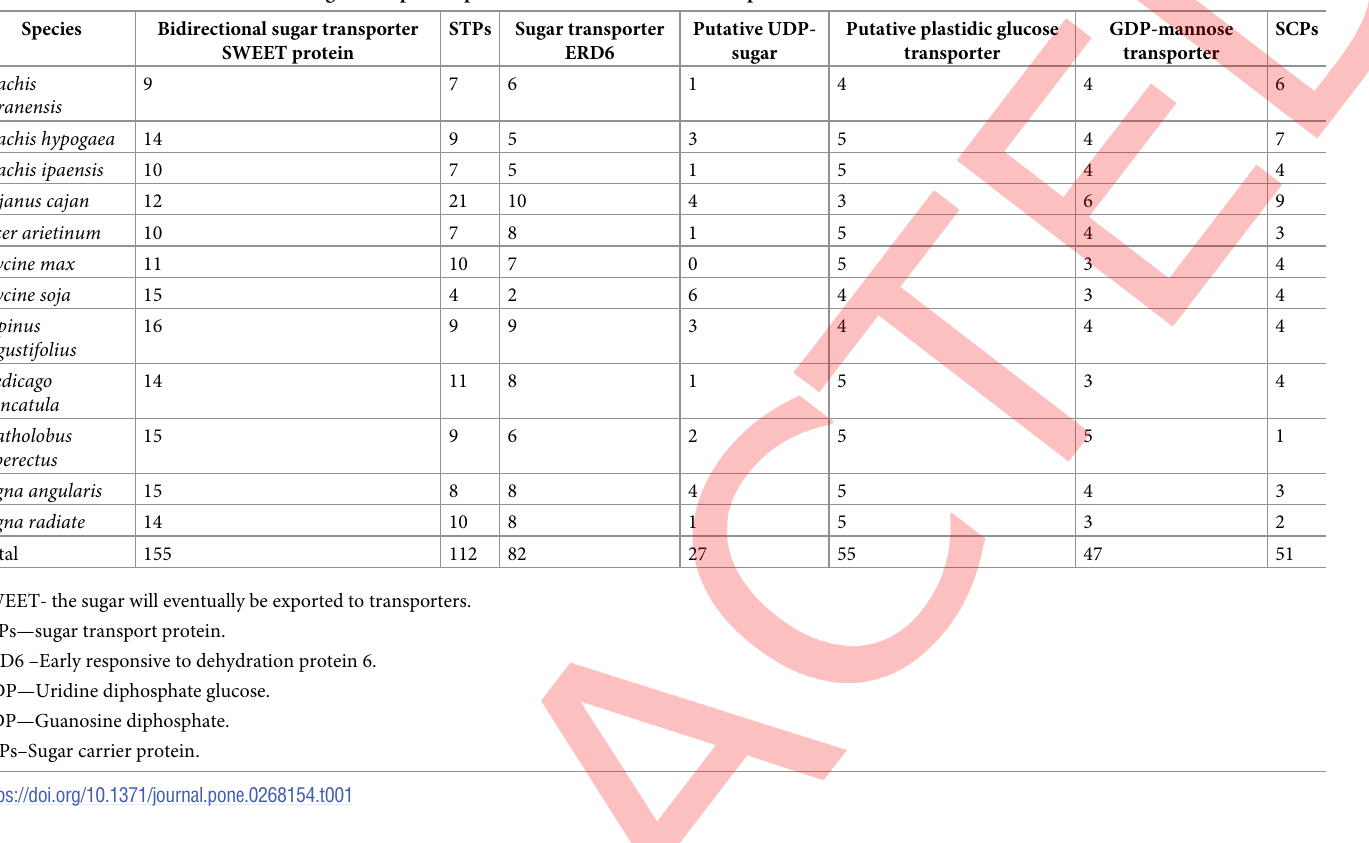
Table 1. Distribution of seven different sugar transporters protein identified in 12 Fabaceae